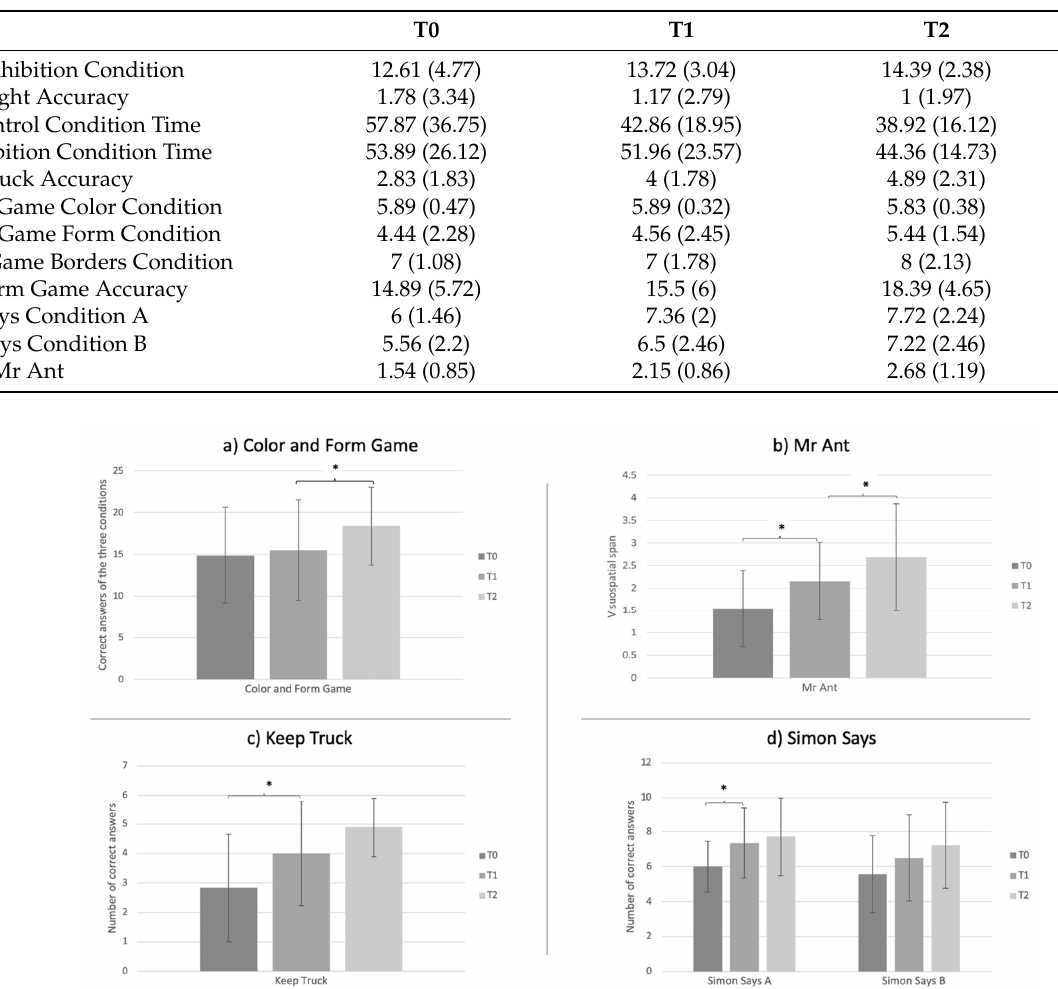
Table 2. Means (standard deviation) obtained in the EFs tests before intervention (control condition, T0-T1) and after the intervention (experimental condition, T1-T2).